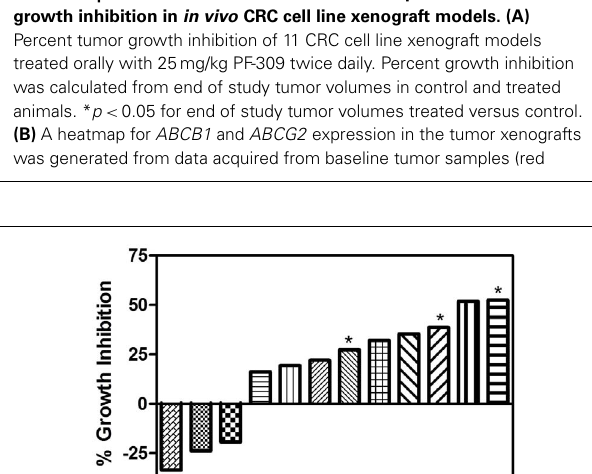
FIGURE 6 | In vivo efficacy of PF-309 in CRC PDTX models. Percent tumor growth inhibition of 12 CRC PDTX models treated orally with 25mg/kg PF-309 twice daily. Percent growth inhibition was calculated from end of study tumor volumes in control and treated animals. * p < 0.05 for end of study tumor volumes treated versus control. A range of responses was observed similar to what was observed in the cell line xenograft models.